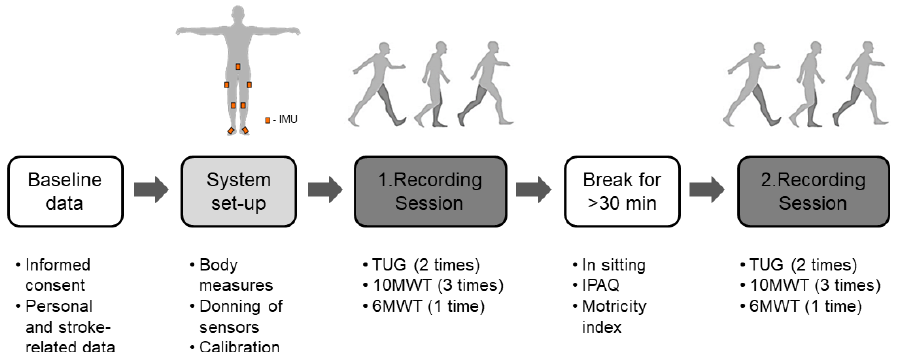
Figure 1. Experimental protocol. The timed up and go test (TUG), ten meter walk test (10MWT), and six-minute walk test (6MWT) were recorded with an IMU-based sensor suit in sessions 1 (test) and 2 (retest).